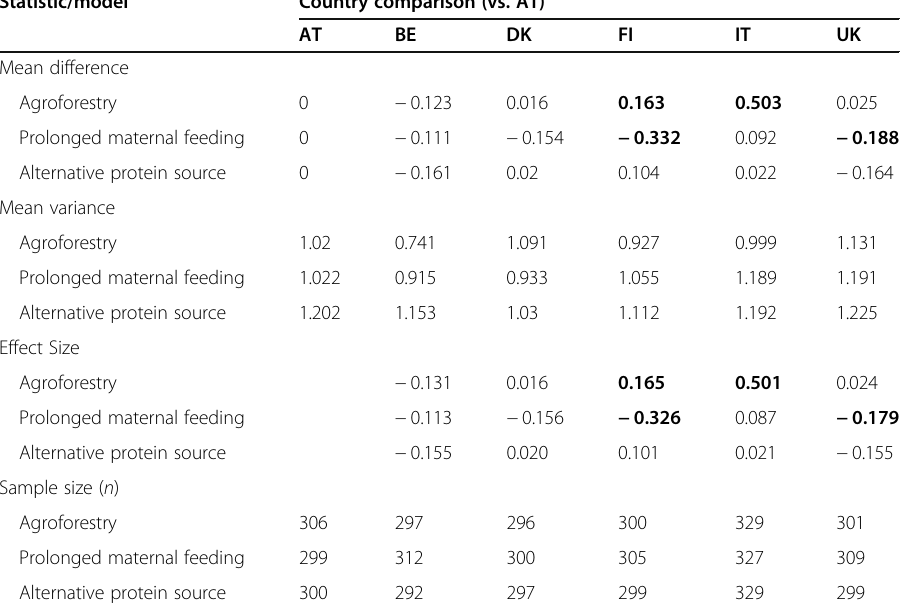
Table 15 Latent mean difference, variance and effect sizes for attitude — country comparisons (reference country: AT) Statistic/model Country comparison (vs.